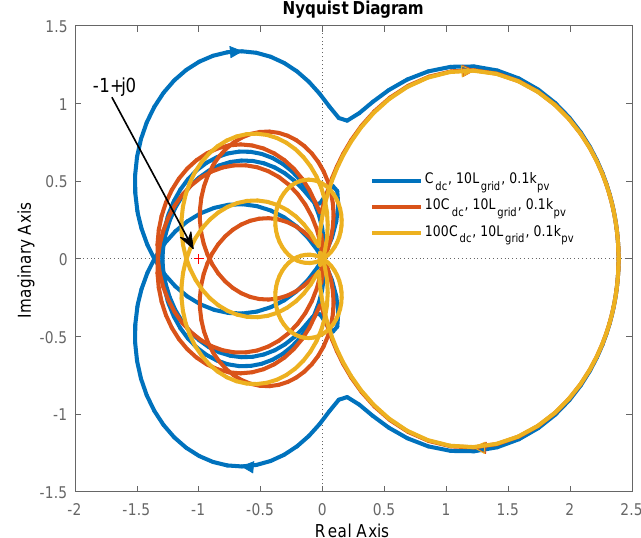
Figure 28. Stability sensitivity to varying DC grid